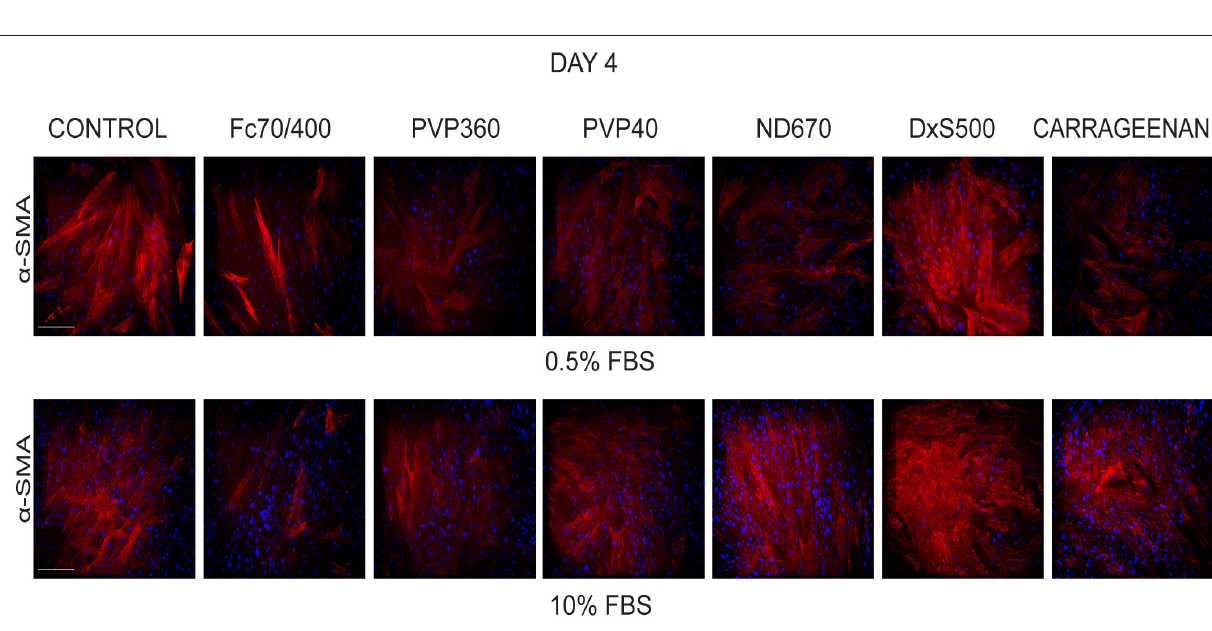
we therefore decided to carry out subsequent experiments in 0.5%